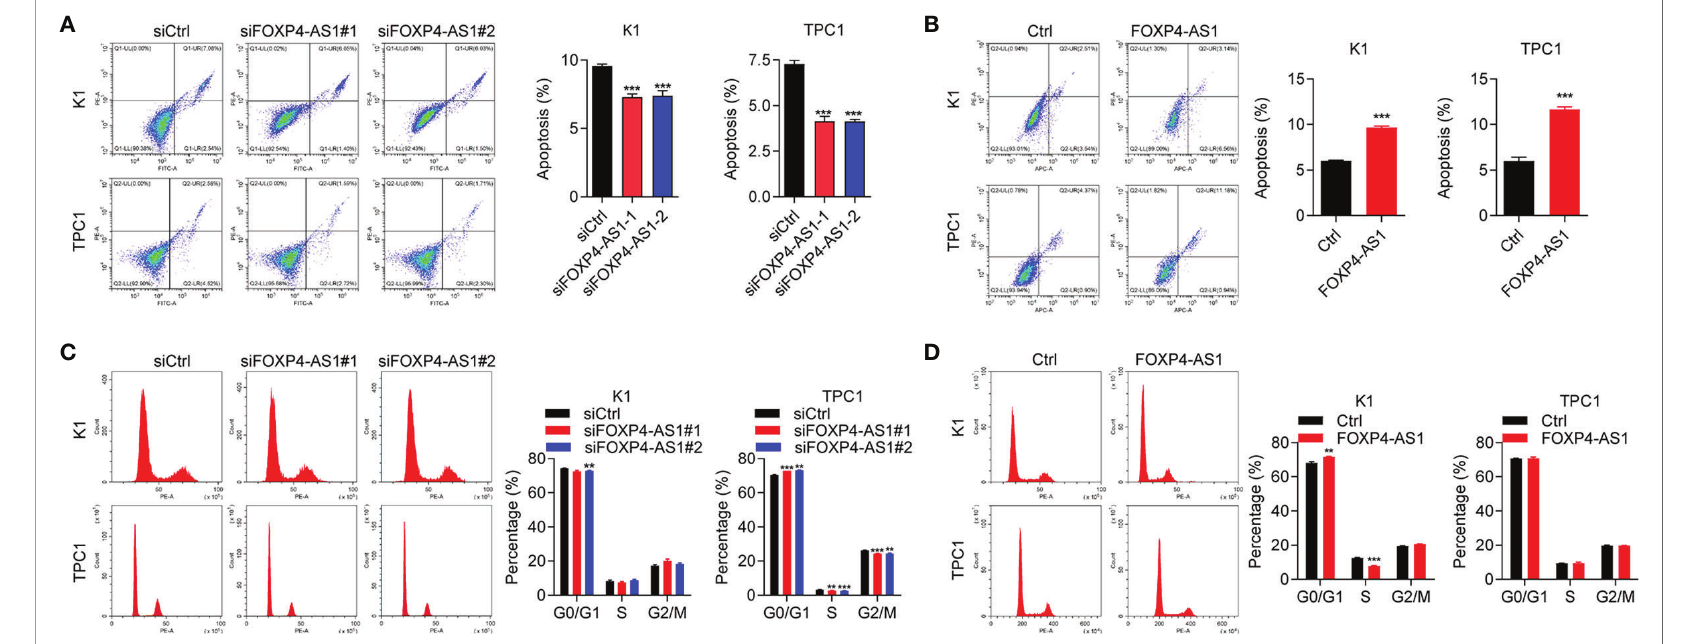
FIGURE 3 | The effect of FOXP4-AS1 on apoptosis and cell cycle of papillary thyroid carcinoma cells. (A) The apoptotic rate of TPC1 and K1 cell lines transfected with FOXP4-AS1 was analyzed by fl ow cytometry. (B) The apoptotic rate of K1 and TPC1 cell lines following FOXP4-AS1 overexpression was analyzed by fl ow cytometry experiment. (C) Cell cycle distribution ratio of K1 and TPC1 cell lines transfected with FOXP4- AS1 and corresponding control was analyzed by fl ow cytometry. (D) Cell cycle distribution of K1 as well as TPC1 cell lines following FOXP4-AS1 overexpression was examined by fl ow cytometry. * p < 0.01, *** p <